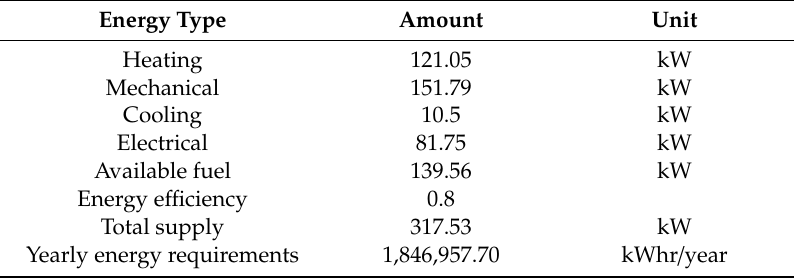
Table 6. Total plant power and energy